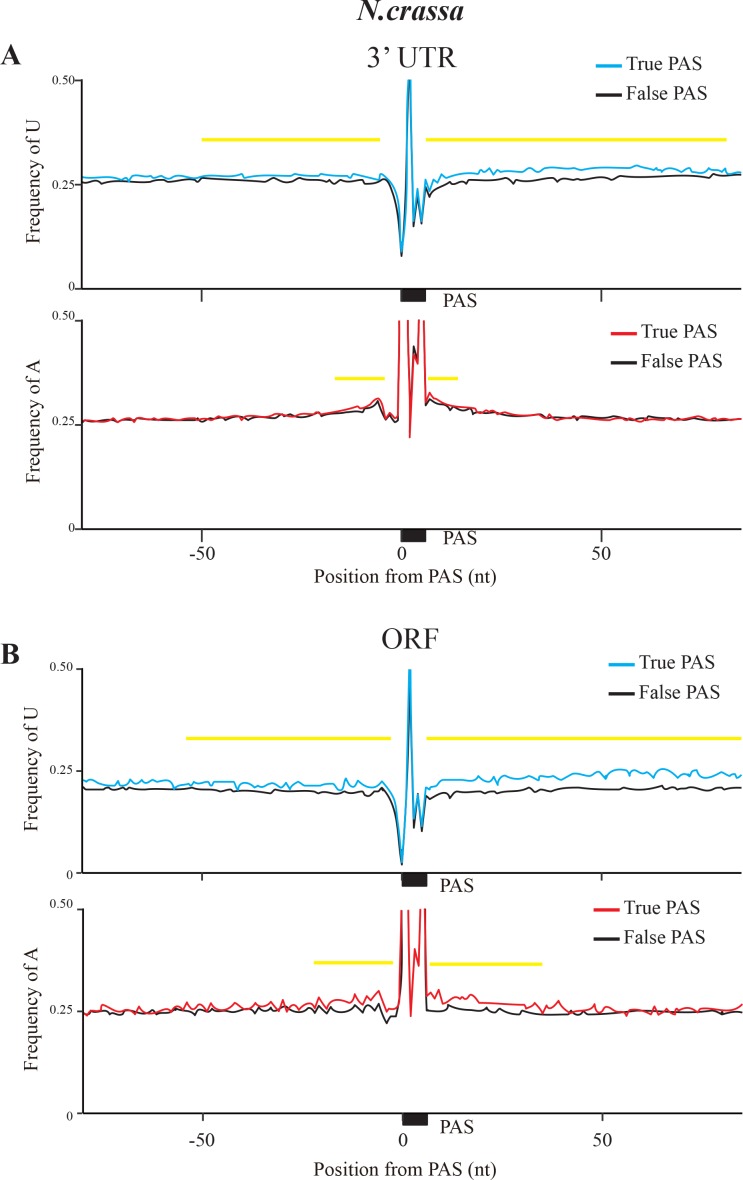
Nucleotide composition (U top panel and A bottom panel) surrounding PAS motifs in 3’ UTR (A) and coding region (B).True PAS means at least a poly(A) site was identified by 2P-seq within the 5–35 nt downstream of PAS motif, and False PAS has no poly(A) site was identified in this region. 0 indicates the position of the first nucleotide of PAS, the black bar indicates the position of PAS motif, and the yellow lines indicate the regions shows different between True PAS and False PAS. A/U contents above 0.5 are not shown.